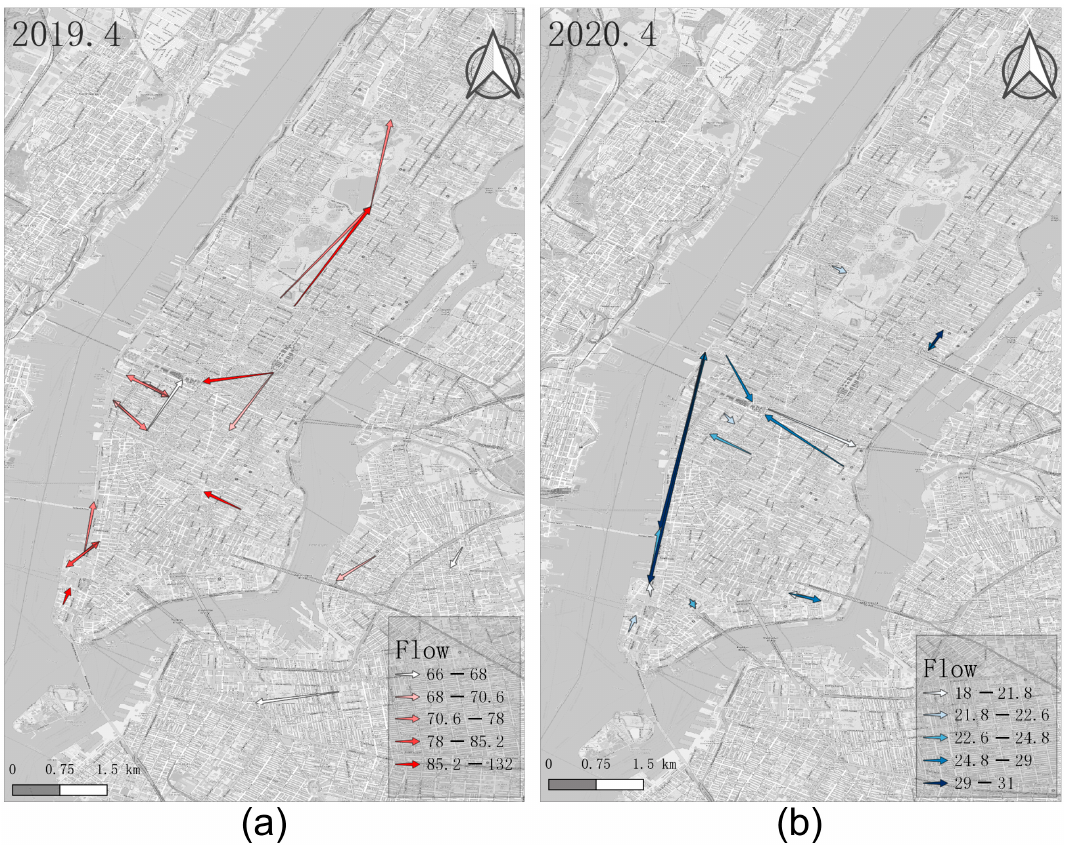
Figure 12. Top 20 flow edges of different start and end stations ( a ) Edges in 2019.4 ( b ) Edges in 2020.4.